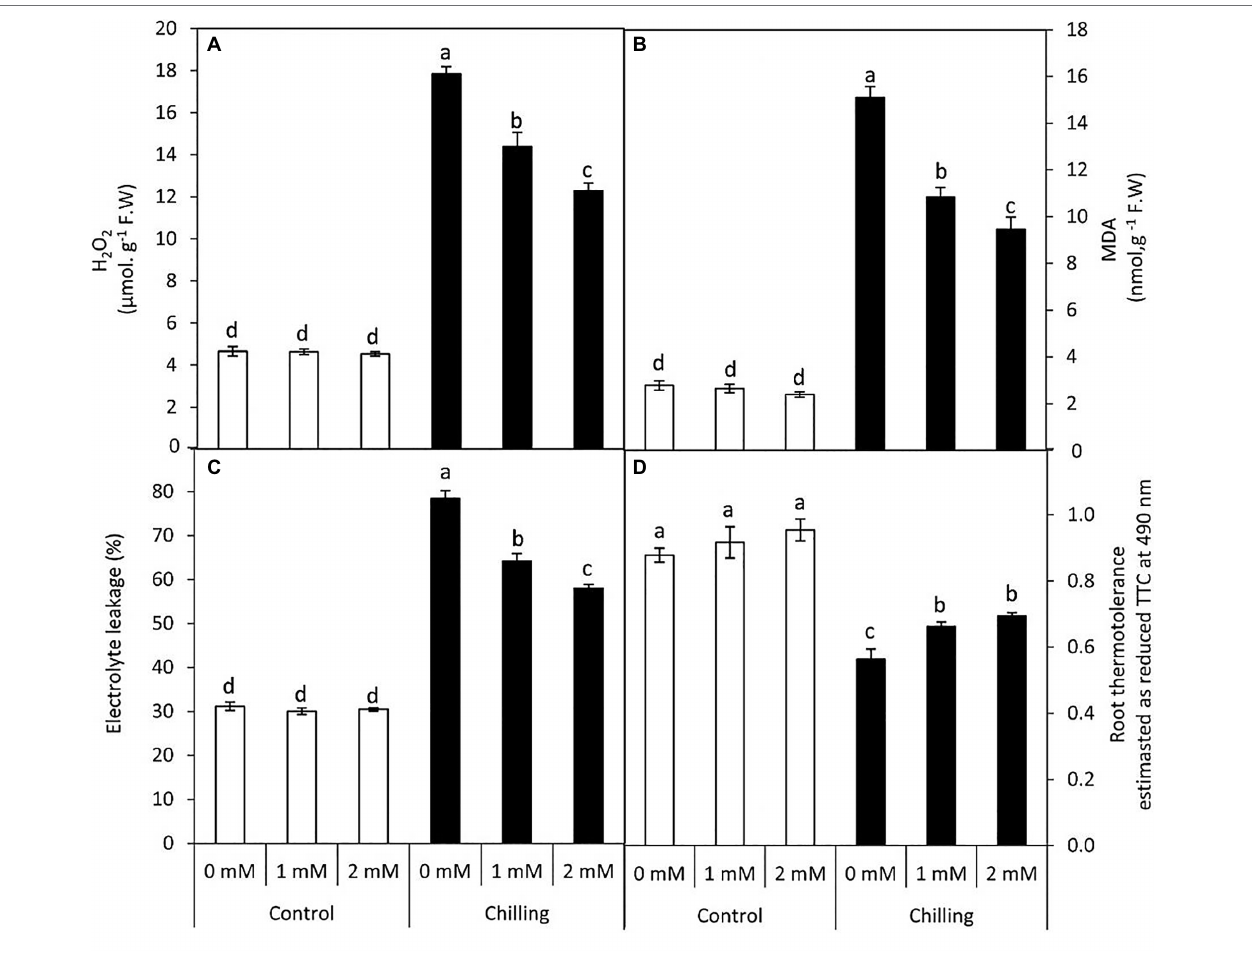
FIGURE 4 | Effect of γ -aminobutyric acid (GABA) as a foliar application at 1 and 2 mM on leaf oxidative damage and root tissues thermotolerance of tomato plants cv “Super marmende” growing under normal (25°C/20°C day/night ) and chilling conditions (5 days/4ºC for 6 h/day) followed by 2 days recovery. (A) , hydrogen peroxide (H 2 O 2 ); (B) , malondialdehyde (MDA); (C) , electrolyte leakage, and (D) , root thermotolerance as reduced TTC. Data followed by the same letters ± SE are not significant according to Duncan multiple rang test P ≤ 0.05. The white columns refer to the control conditions and the black columns refer to the chilling